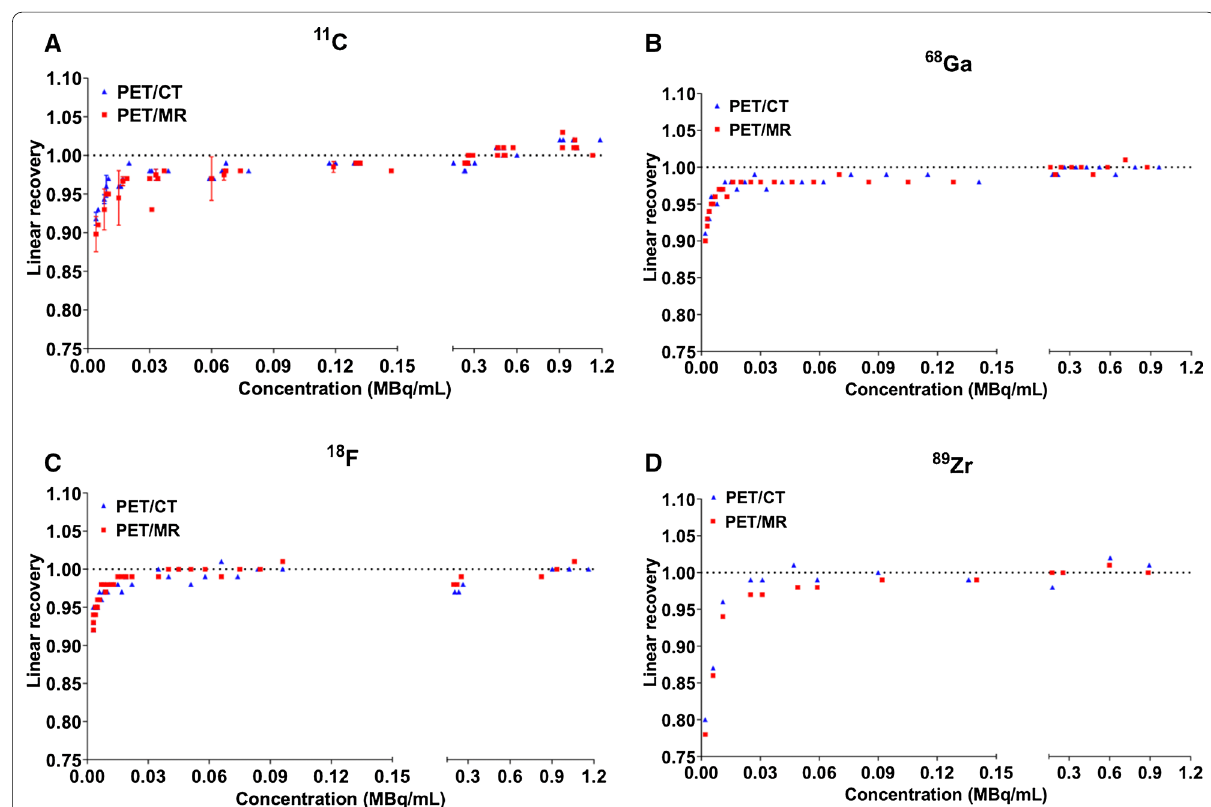
Fig. 1 Linear recovery of the PET/CT and PET/MR scanners as assessed with 11 C (n impaired linearity at doses < 0.05 MBq/mL for each of the